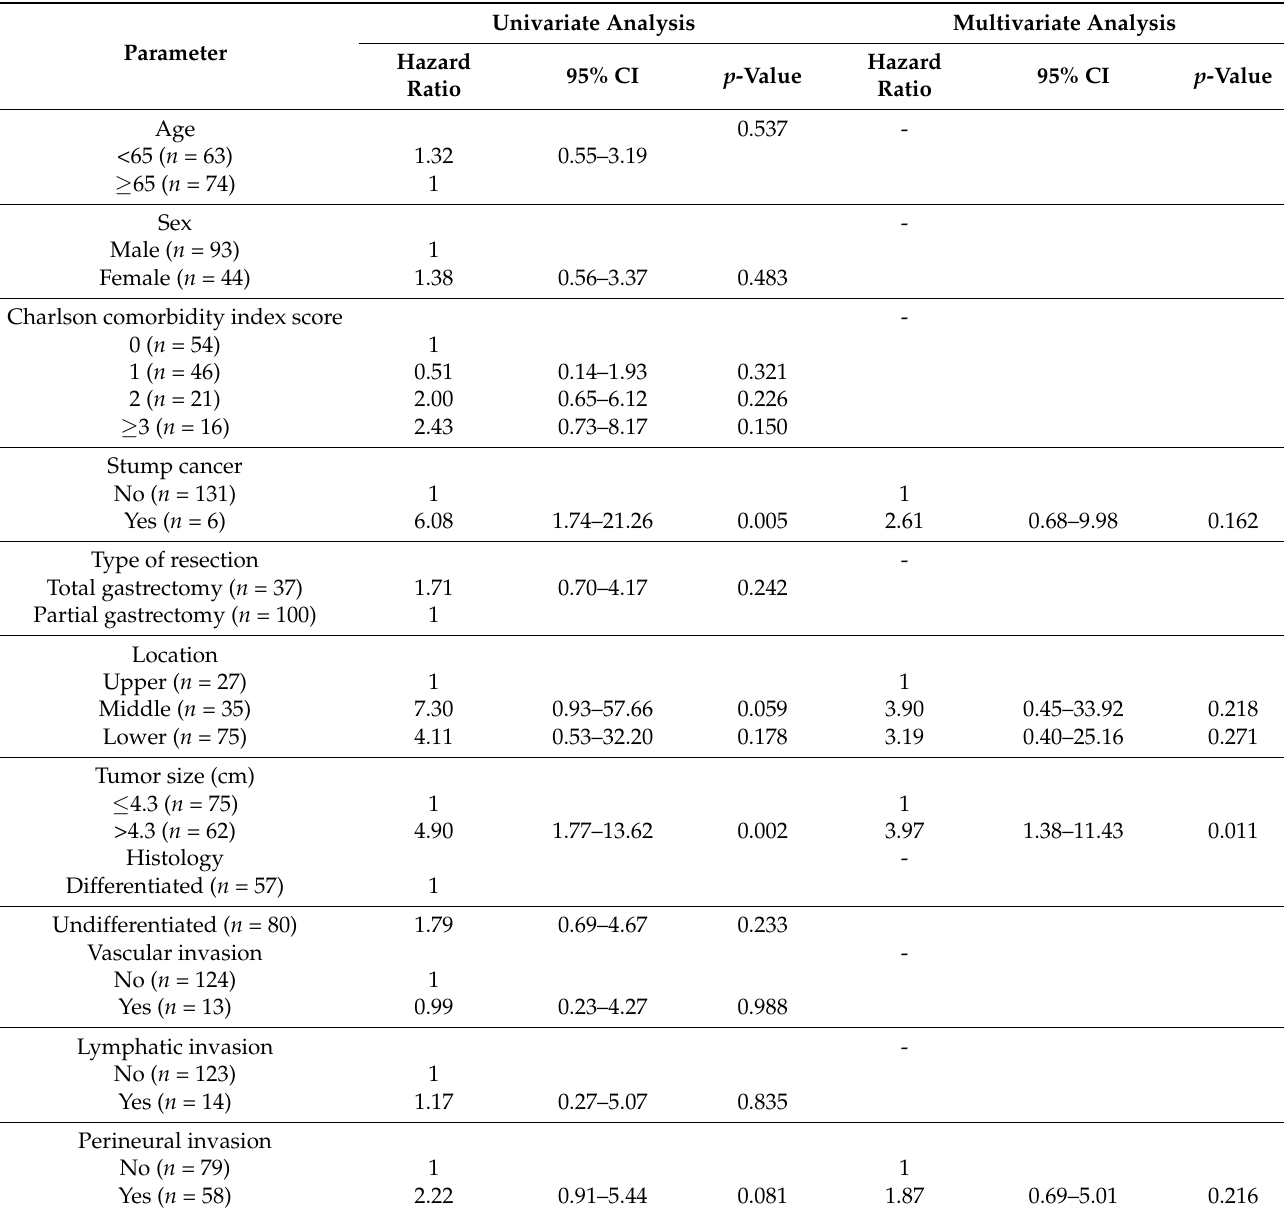
Table 4. Univariate and multivariate analyses of prognostic factors for cancer-specific